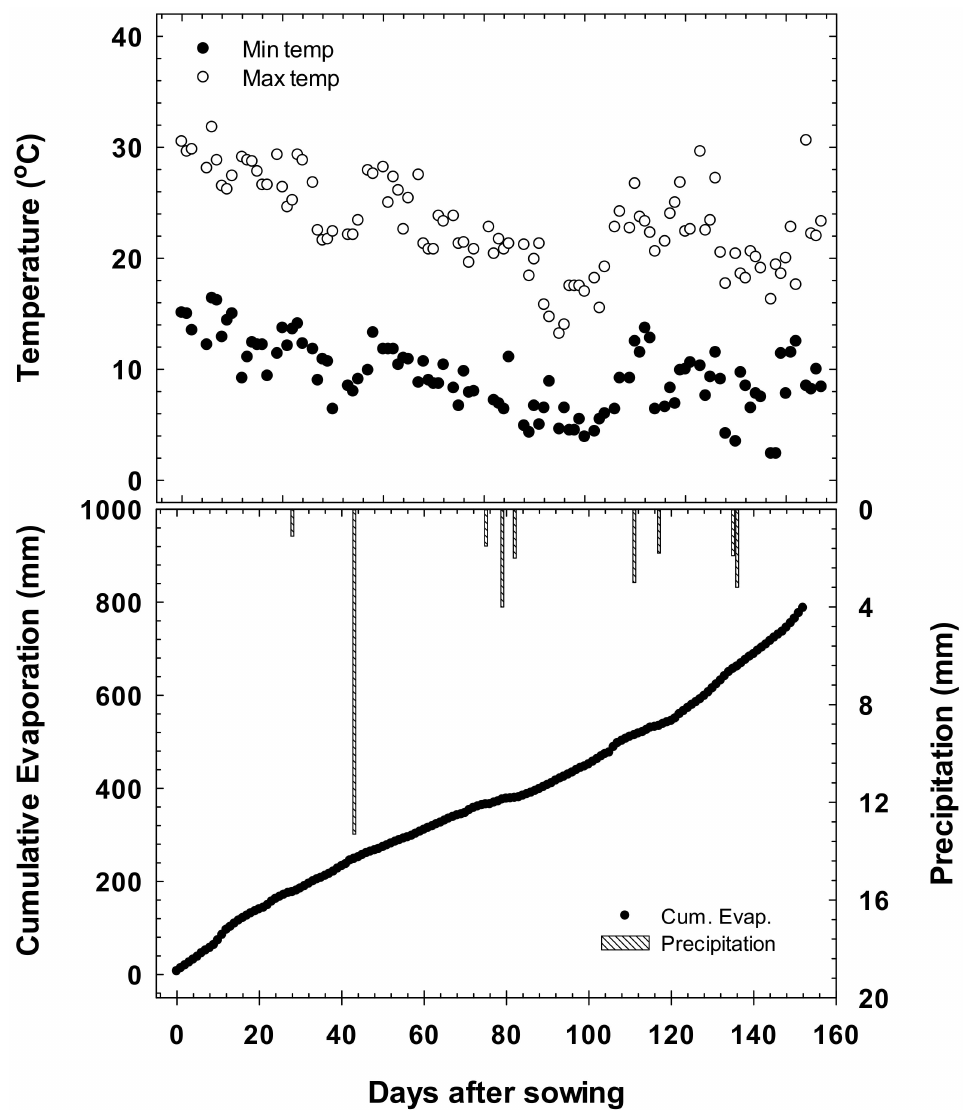
Figure 1. ( a ) Min. and max. Temperature; ( b ) cumulative evaporation (mm), and daily precipitation (mm) during the growing season starting from sowing